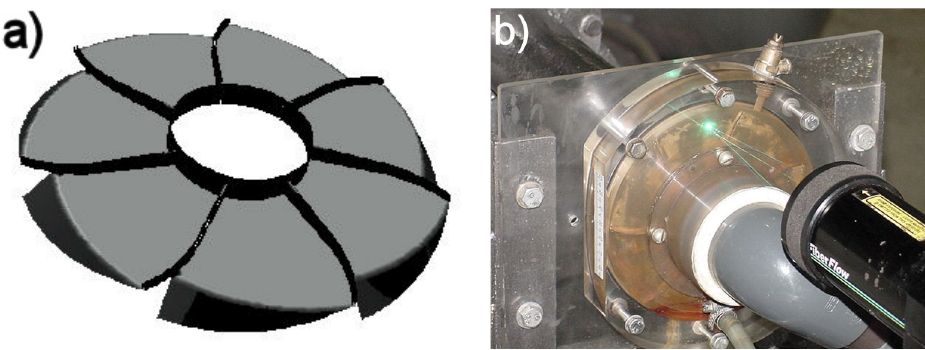
Figure 4. A4 stator with a crossover shaped as a spherical surface; ( a ) 3D model; ( b ) stator installed in the model pump.